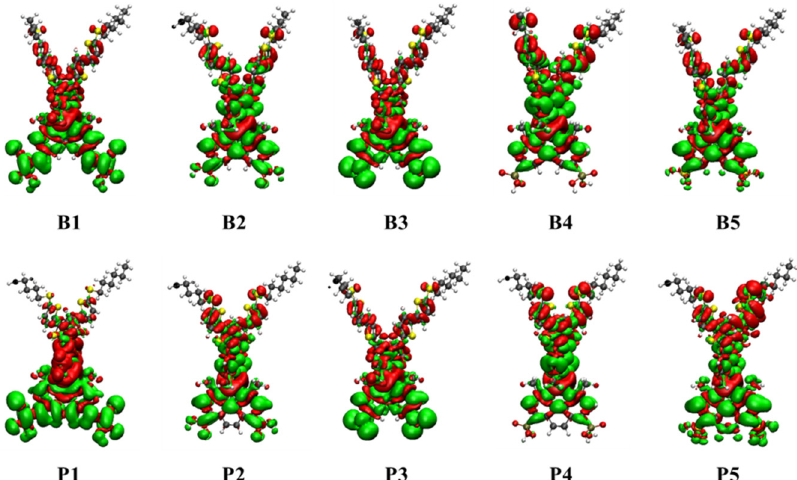
Figure 5. The electron density differences ( Δ ρ ) for the studied dyes. The red surface identifies the region in which the electron density decreases. The green surface identifies the region in which the electron density increases.